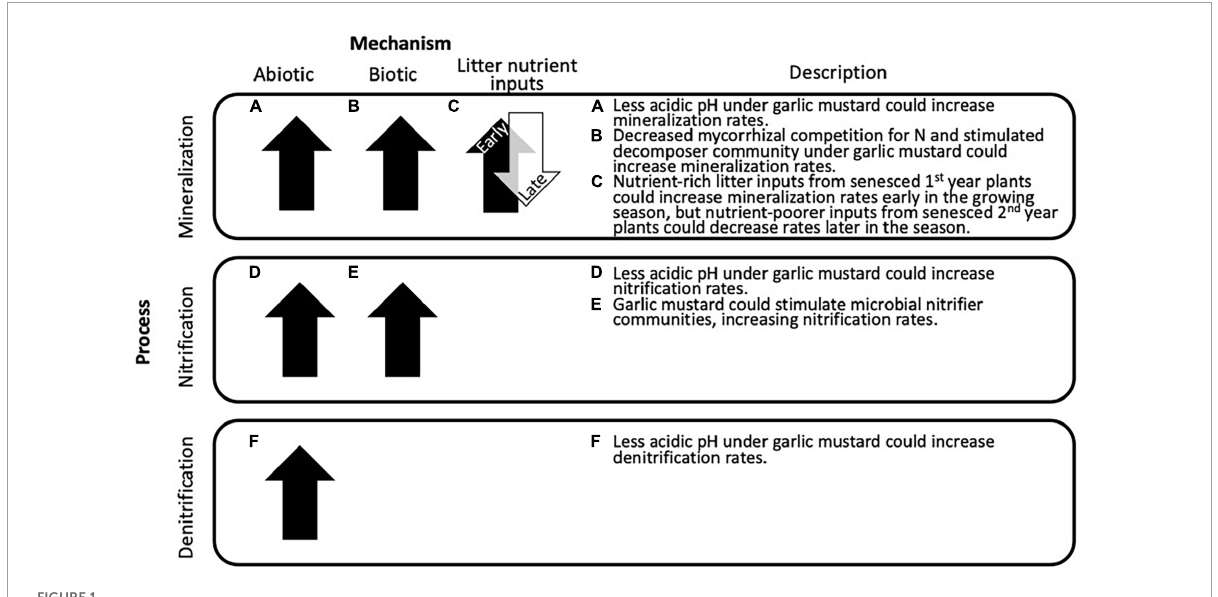
FIGURE1 Conceptual diagram depicting proposed mechanisms for garlic mustard to influence soil N cycling and hypothesized effects these mechanisms will have on N cycling